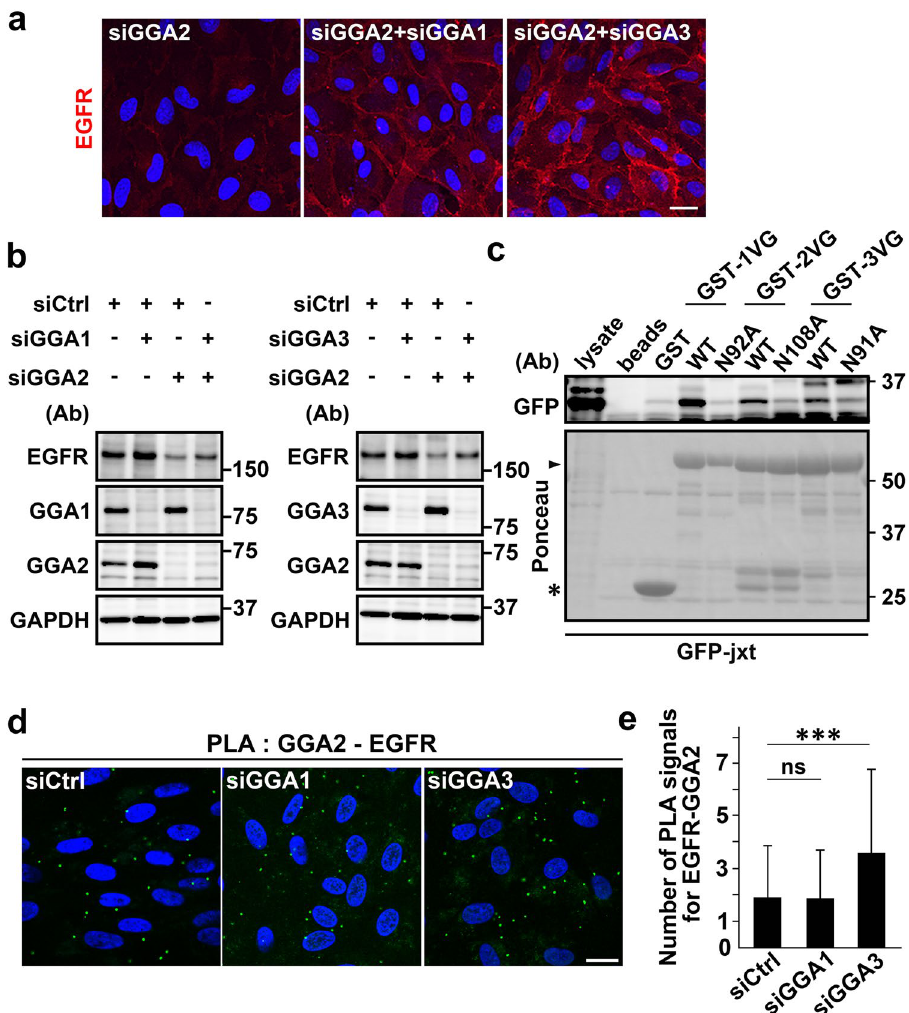
Figure 5. Simultaneous depletion of GGA1 or GGA3 with GGA2 restores EGFR expression. ( a and b ) ARPE- 19 cells were transfected with control (siCtrl), GGA1 (siGGA1), GGA2 (siGGA2), or GGA3 (siGGA3) siRNAs alone, or with a combination of siGGA2 and siGGA1, or siGGA2 and siGGA3 as indicated. Cells were then fixed for immunofluorescence staining with anti-EGFR antibody ( a ), or were lysed for western blot analysis with antibodies against EGFR, GGA1, GGA2, GGA3, and GAPDH ( b ). Nuclei were labeled with Hoechst 33342. Bar, 20 μ m. ( c ) Cell lysates from HEK293 cells expressing GFP-jxt were pulled down using GST fusion proteins containing wild type VHS-GAT (WT) of GGAs or mutant forms (N92A, N108A, or N91A) of VHS-GAT derived from GGA1 (GST-1VG), GGA2 (GST-2VG), or GGA3 (GST-3VG). Bound proteins were immunoblotted using anti-GFP antibody. Ponceau staining is shown at the bottom. Uncropped blots are presented in Supplementary Fig. 7. ( d ) ARPE-19 cells transfected with siCtrl, siGGA1, or siGGA3 were used for PLA to detect GGA2-EGFR interaction (green). Nuclei were stained with DAPI (blue). Bar, 20 μ m. ( e ) PLA signals/cell were counted and mean values ± SD (n = 575 [siCtrl], n = 482 [siGGA1], and n = 448 [siGGA3]) were plotted. Differences were analyzed by one-way ANOVA ( P < 0.001) and Tukey’s honestly significant difference test ( *** P < 0.001, ns: not